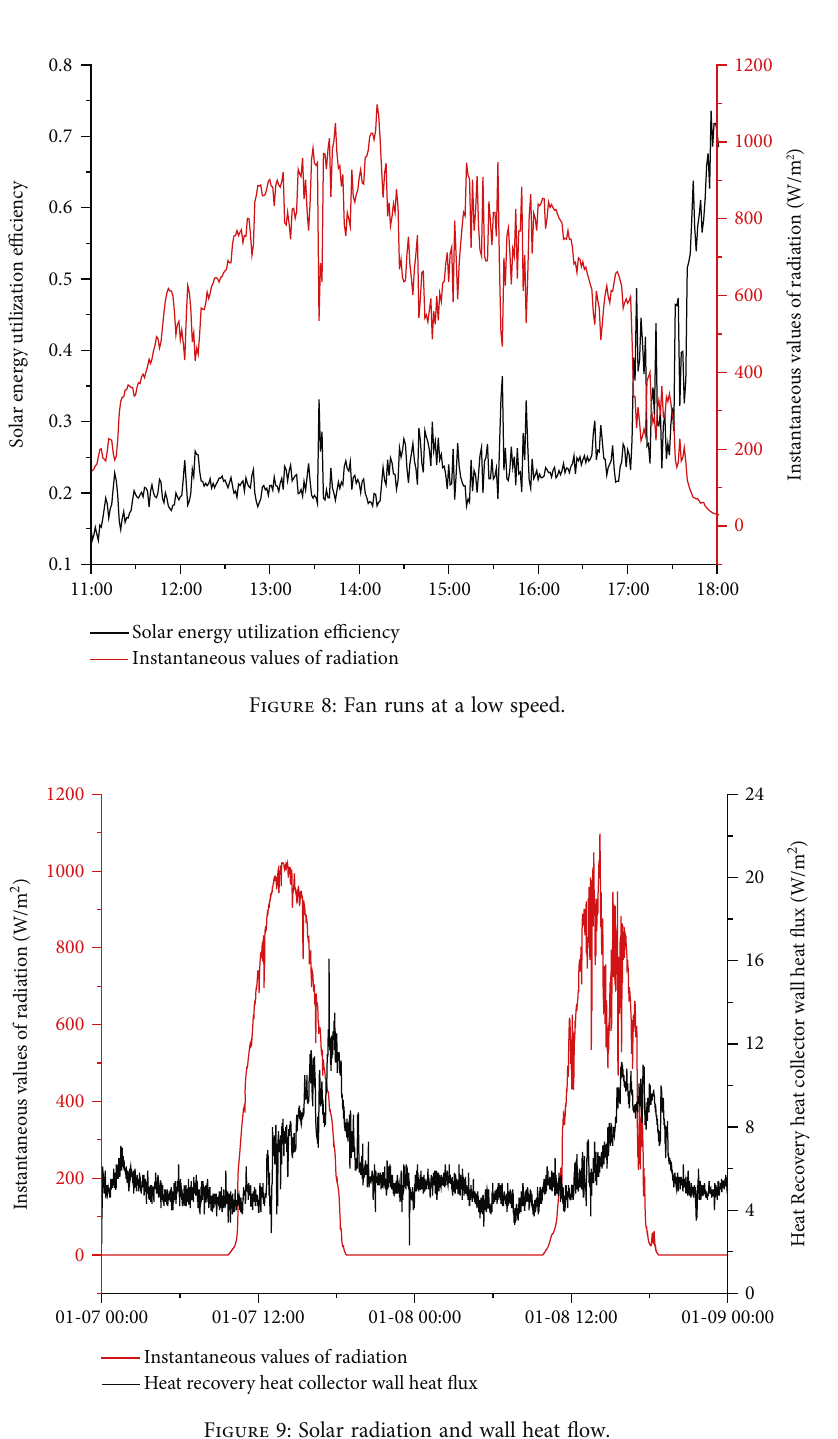
Figure 9: Solar radiation and wall heat fl